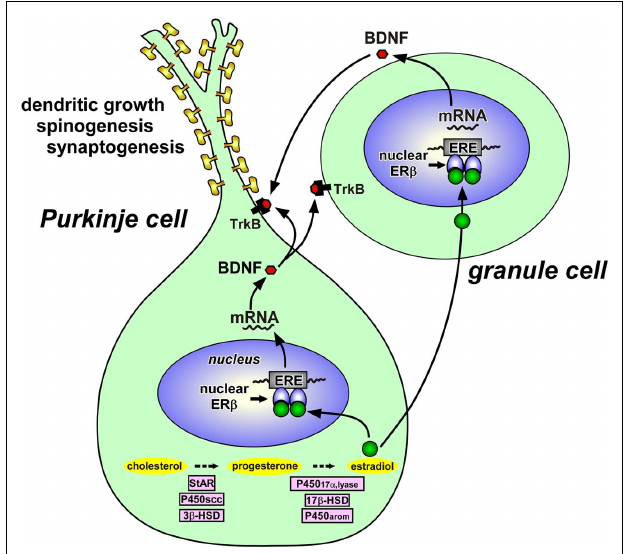
FIGURE 3 | Schematic model depicting possible actions of estradiol in the Purkinje cell during development. Estradiol acts on the Purkinje cell through intranuclear receptor (ER β )-mediated mechanisms that promote dendritic growth, spinogenesis, and synaptogenesis in this neuron by genomic mechanisms. Both Purkinje cells and granule cells express BDNF andTrkB, a receptor for BDNF. Estradiol induces the expression of BDNF, which may act on Purkinje cells and granule cells throughTrkB-mediated mechanisms to promote Purkinje dendritic growth, spinogenesis, and synaptogenesis. See the text for details. StAR, steroidogenic acute regulatory protein; P450scc, cytochrome P450 side-chain cleavage enzyme; 3 β -HSD, 3 β -hydroxysteroid dehydrogenase/ Δ 5 - Δ 4 -isomerase; P450 17 α ,lyase , cytochrome P450 17 α -hydroxylase/c17,20-lyase; 17 β -HSD, 17 β -hydroxysteroid dehydrogenase; P450arom, cytochrome P450 aromatase; ER β , estrogen receptor- β ; ERE, estrogen response element; BDNF, brain-derived neurotrophic factor;TrkB, BDNF receptor.